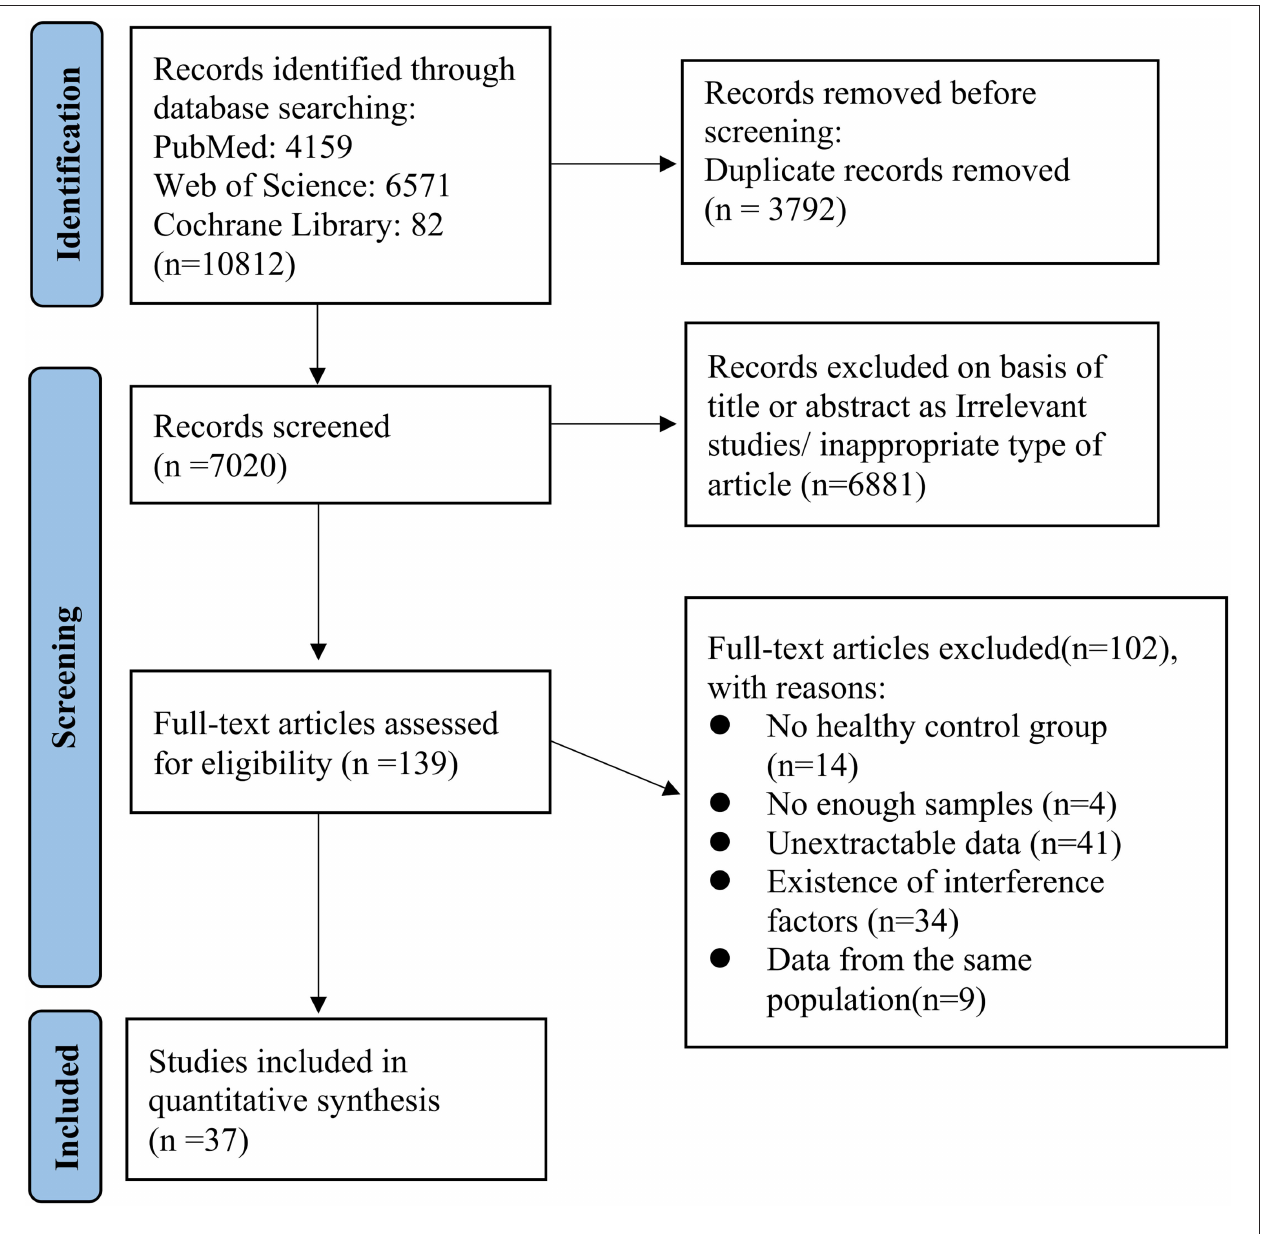
FIGURE 2 | Flow diagram of article